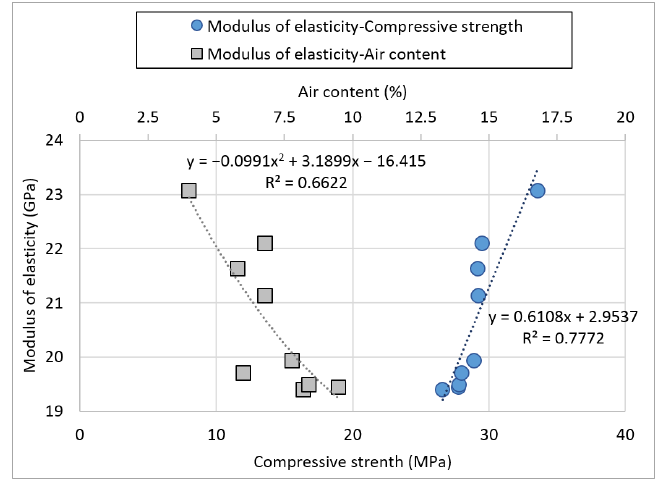
Figure 12. Effect of the modulus of elasticity on compressive strength and air content.